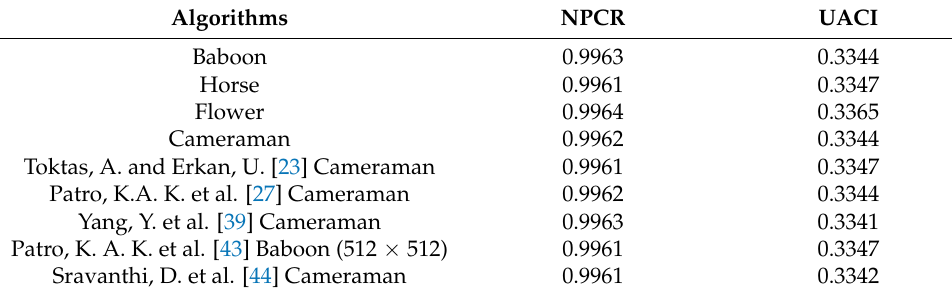
Table 9. The values of NPCR and